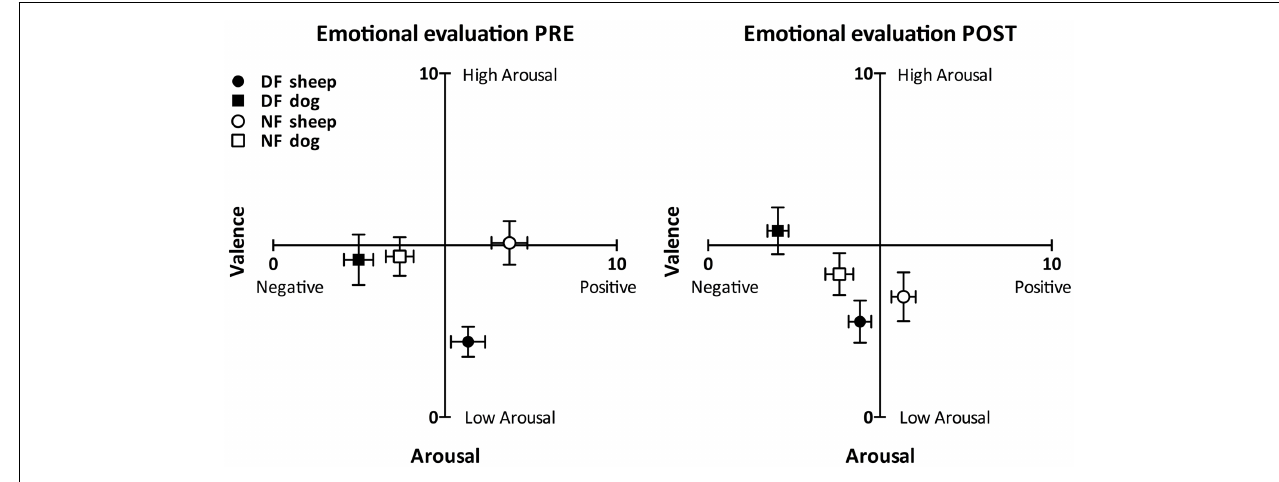
evaluations.The perceived valence of the dog sound was more negative than the perceived valence of the sheep sound within each group and in both emotional evaluations. Moreover, within each group, while the sheep sound was rated as positive or neutral, the dog sound was rated as